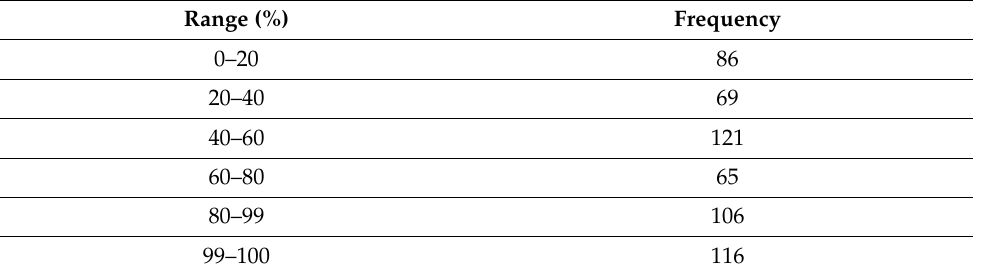
Table 9. Accumulated asset depreciation histogram data.